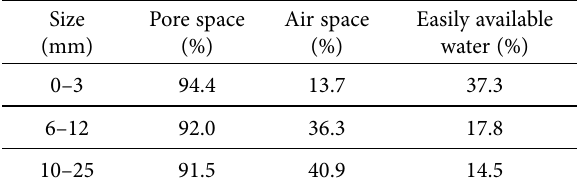
Table 3. Physical properties of fractionated peat according to Maher and Prasad